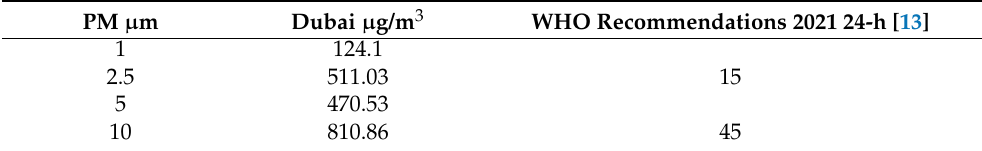
Table 1. Particulate matter concentrations in Dubai on 25 June 2022 (measurements by